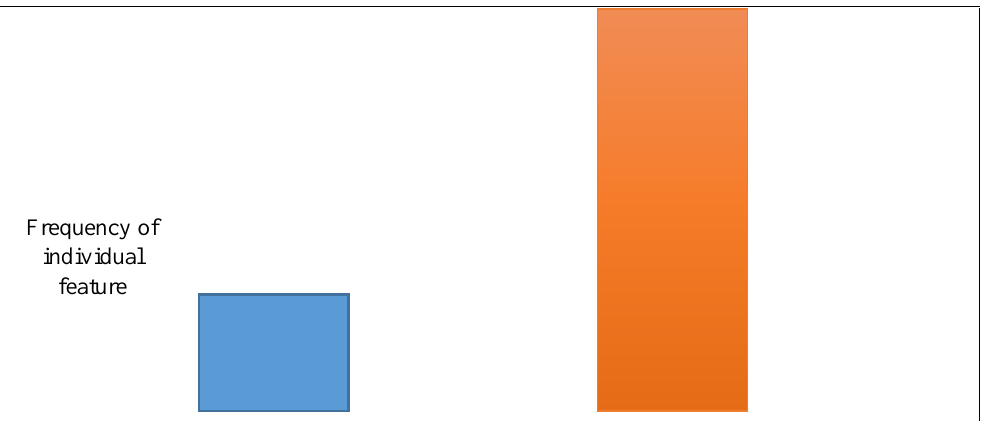
Figure 7. frequency of objectives in Pareto